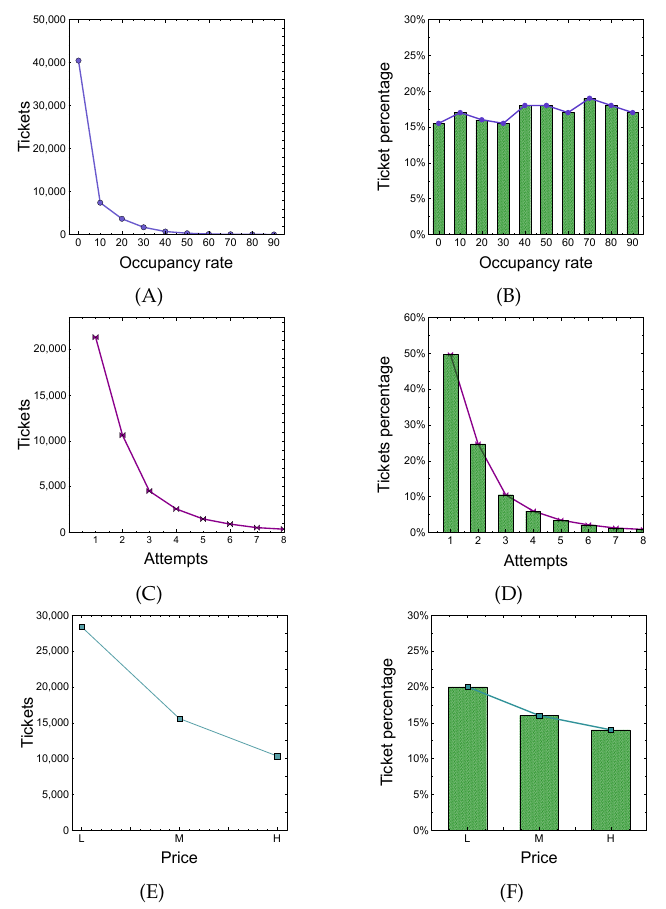
Figure 7. No. and percentage of purchased tickets considering the occupancy rate for a bus (OCCR), the number of attempts (NA), and the fare of a ticket